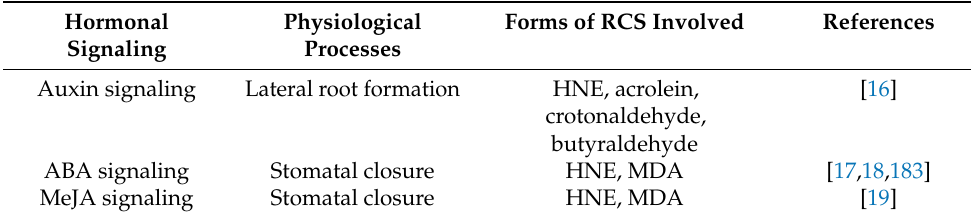
Table 2. Summary of RCS-mediated protein carbonylation in